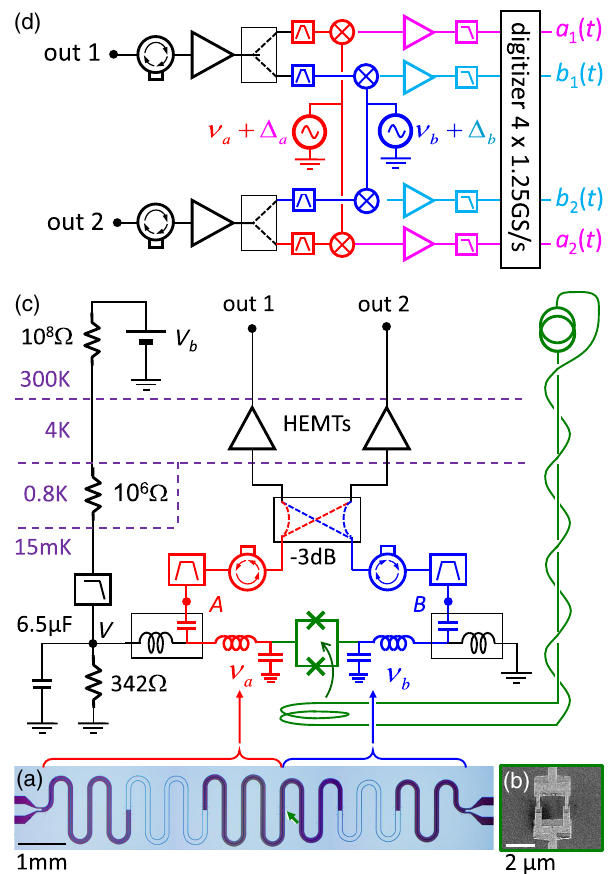
FIG. 2. Implementation of the experiment sketched in Fig. 1. (a) Optical micrograph of the circuit on its silicon chip (see text). The green arrow indicates the position of the SQUID. (b) Scan- ning electron micrograph of the SQUID used as a tunable Josephson element. (c) Schematic electrical circuit connecting the chip at 15 mK (green SQUID and red and blue LC resonators) to room temperature (see text). (d) Schematic room-temperature setup for heterodyning and digitizing the outgoing fields. The red and blue filters are ∼ 700 MHz wide and centered around ν ν , respectively. The microwave signals are then down-converted, b amplified, and low-pass filtered with a ∼ 600 MHz cutoff frequency and then digitized, as shown by the magenta and cyan